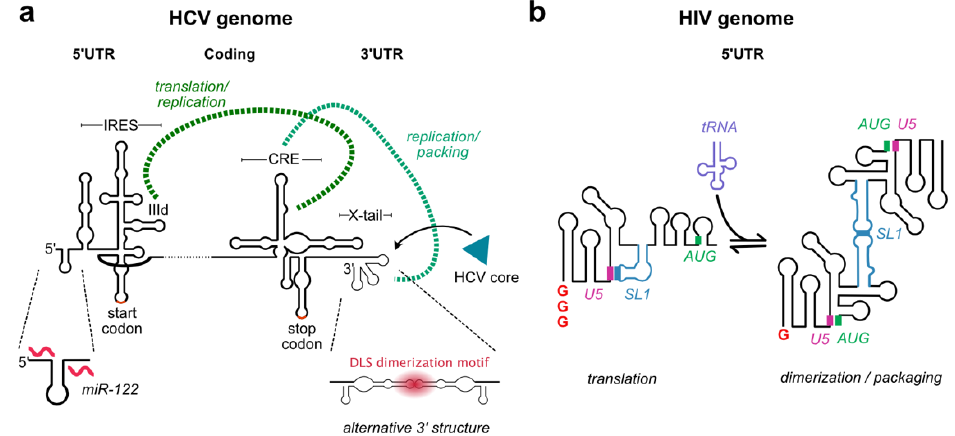
Figure 4. RNA structural switches and long-distance interactions regulate the balance between genome replication, packaging, and translation. ( a ) The HCV life cycle is regulated by a complex network of long-distance intra-molecular interactions and inter-molecular interactions. The packaging site which binds to the HCV core protein resides in the 3 ′ untranslated region (3 ′ UTR). A long-distance base pairing between the cis- acting element (CRE) in the coding region and the X-tail in the 3 ′ UTR regulates the balance between replication and packaging (light green dotted line). A long-distance interaction between the CRE and the internal ribosome entry site (IRES) regulates the balance between replication and translation (dark green dotted line). The 3 ′ UTR is alternatively structured, leading to the formation of homodimers through an intermolecular interaction. The HCV 5 ′ UTR binds the host microRNA miR-122 to regulate different aspects of HCV replication; ( b ) A structural switch in the HIV-1 5 ′ UTR regulates the balance between genome translation and packaging. Transcripts beginning with three G residues fold into a monomer conformation and are preferentially translated. Transcripts beginning with one G residue fold into a dimer conformation. Structural switching is mediated by mutually exclusion interactions between regions U5 (pink), SL1 (blue), the AUG region (green), and a host tRNA (purple).